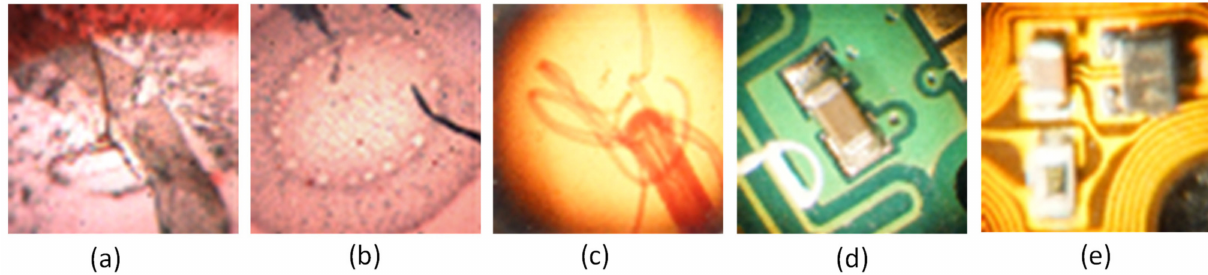
Figure 7. Different types of specimen: ( a ) honeybee, ( b ) Z. Mays, ( c ) hydra, ( d ) chip, and ( e ) printed circuit board (PCB).